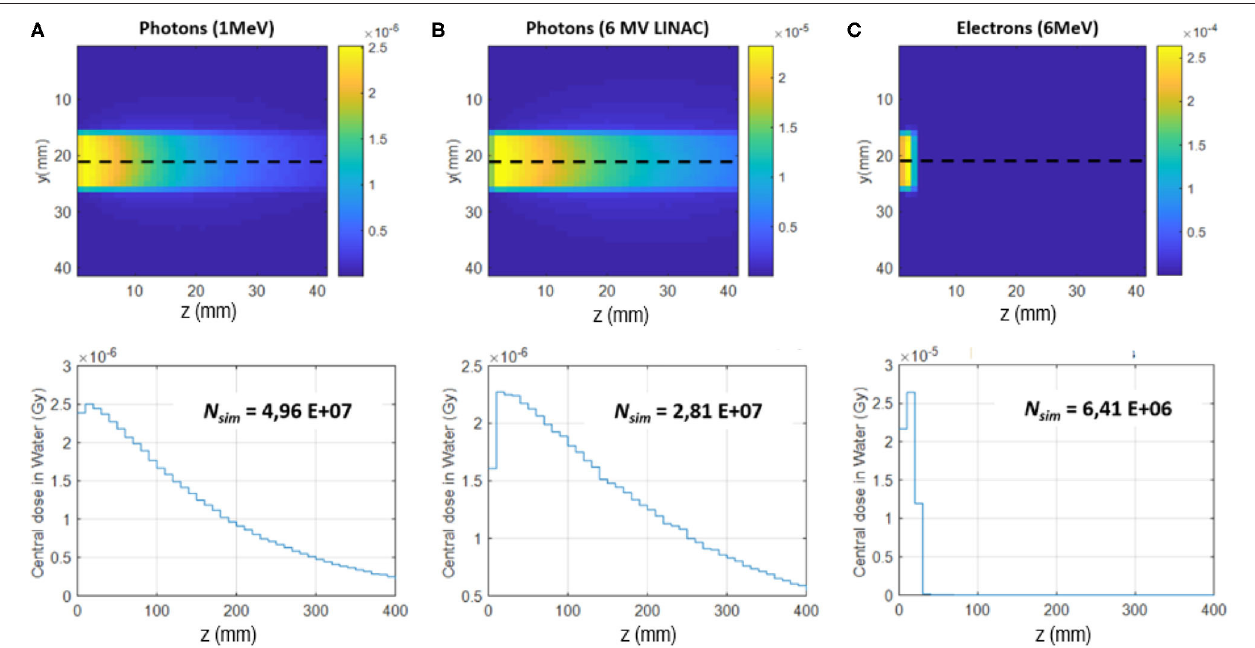
FIGURE 6 | Upper plots: simulated dose distribution maps expressed in Gy, averaged in 1 cm 3 voxels, in the central yz plane. Lower plots: dose distributions along the central axis (i.e., along the dotted lines of the upper plots). The results correspond to a 10 × 10 cm 2 uniform field in a 40 × 40 × 40 cm 3 water phantom irradiated with (A) 1 MeV monoenergetic photons, (B) photons from 6MV LINAC, and (C) 6 MeV electrons. The number of particles N sim used in the simulation is